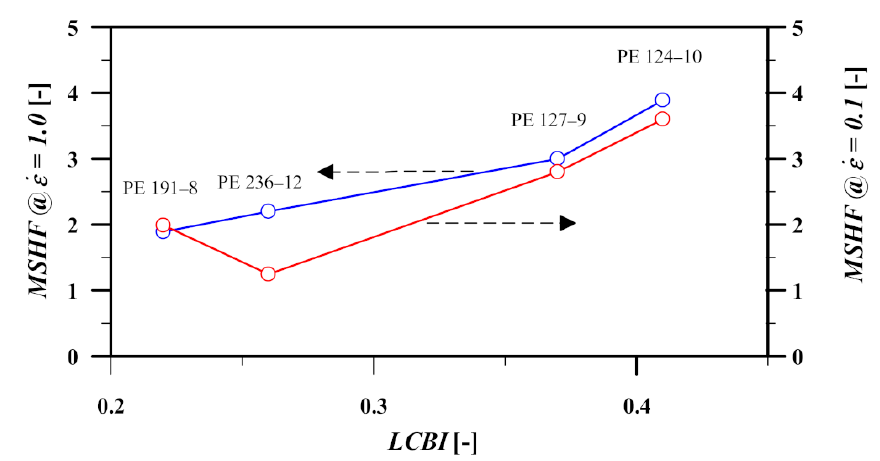
Figure 7. Relationship between MSHF and long chain branching index (LCBI). Data obtained by digitization of figure s3 of [23].